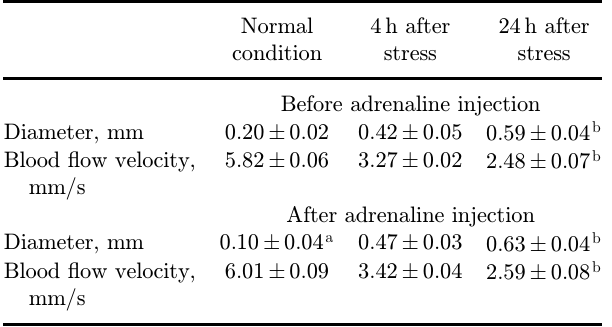
Normal 4 h after 24 h after condition stress stress Before adrenaline injection